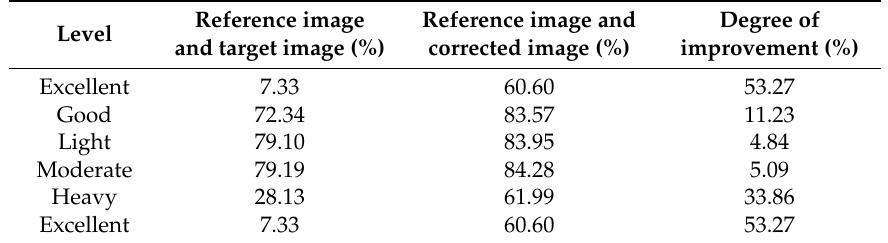
Table 4. Similarity of different